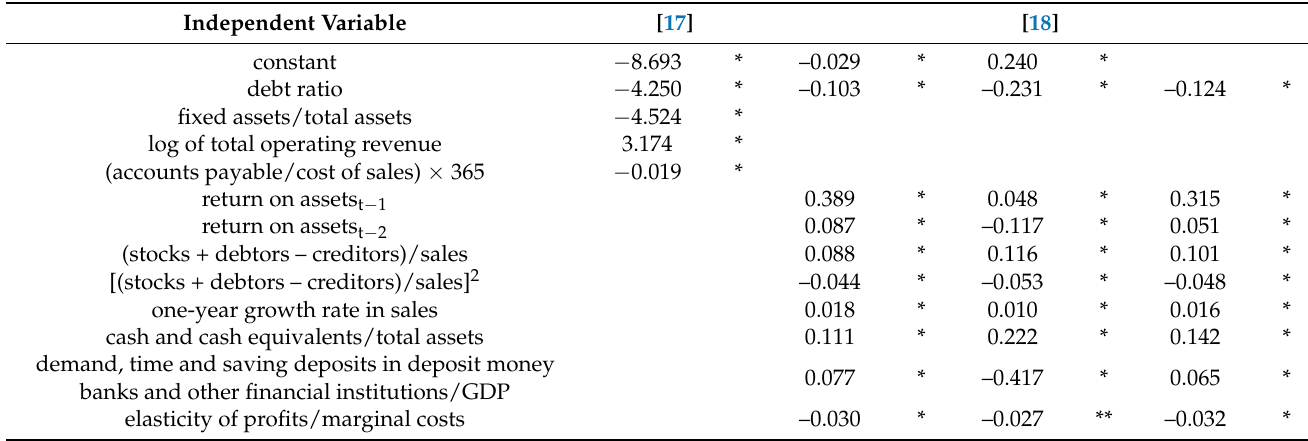
Table 15. Summarizing the results of previous research from Central